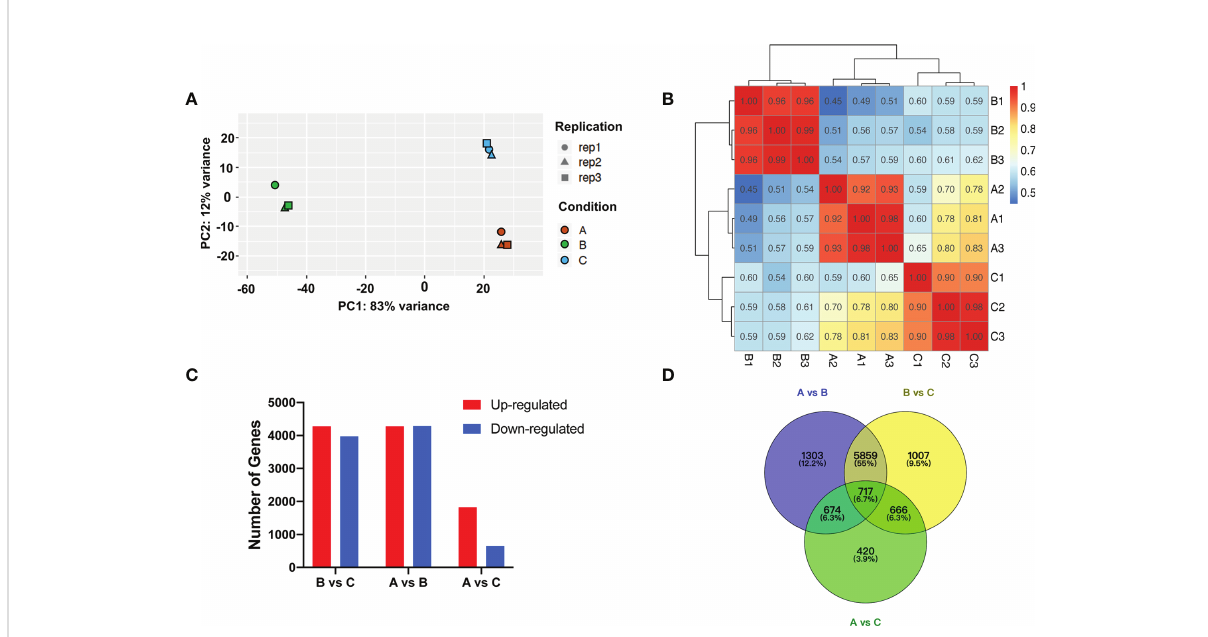
FIGURE 3 Transcriptomic analysis after cold storage. (A) Principal component analysis of differential expressed genes. Different symbols and colors represent different replicates and treatment conditions, respectively. (B) Correlation analysis of patterns of RNA-Seq in each group. (C) Number of up- and downregulated genes among groups. (D) Venn diagram of number of DEGs among